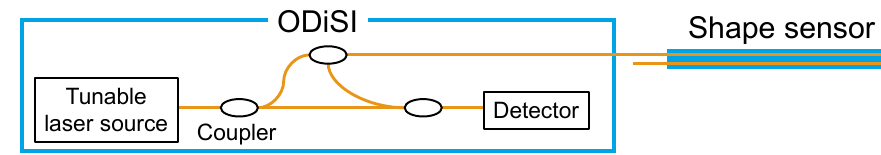
Figure 3. Schematic of measurement system.